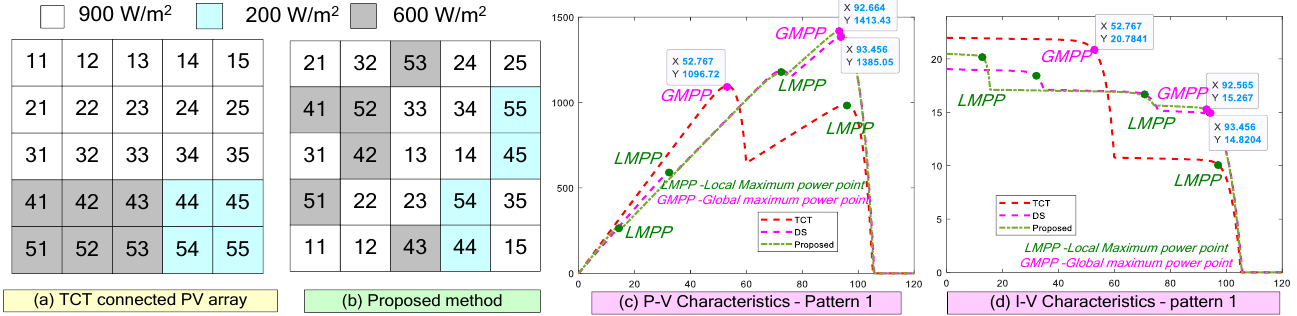
respectively. After analysis, it was perceived that the proposed method and the DS method have obtained global power close to V oc ; however, the shade dispersion ability with the proposed scheme is maintained at a high level. The I–V and P–V characteristics of pattern 1 are shown in Figure 3c,d,